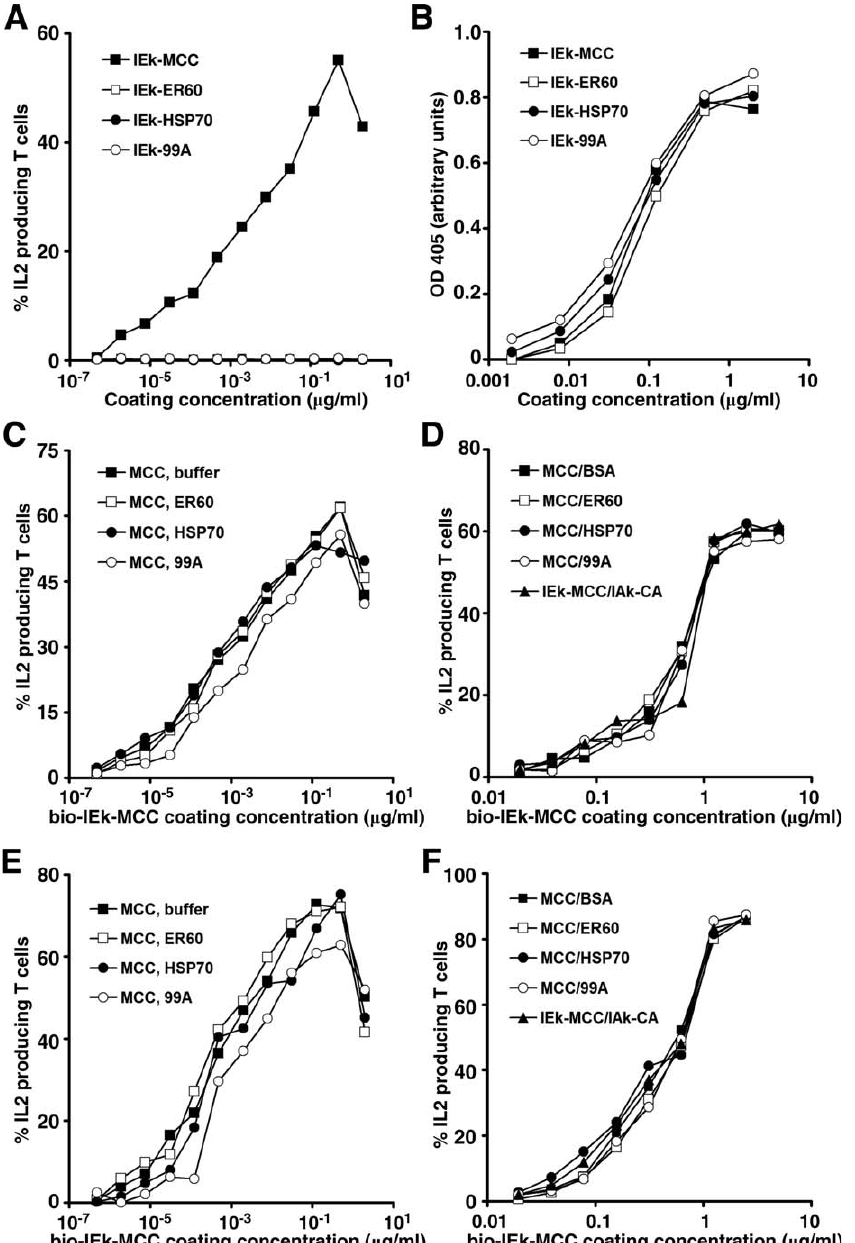
Figure 3. Very Low Numbers of Agonist IEk Anchored on a Fixed Surface Induce AD10 T Cell IL2 Production, Independent of Endogenous or Null IEk, or IAk (A) Bio-IEk-MCC, bio-IEk-ER60, bio-IEk-HSP70, or bio-IEk-99A at the indicated concentrations were added to 96-well plates precoated with streptavidin and incubated for 18 h at 37 8 C. AD10 CD4 þ T cells were added to the wells and stimulated for 7 h prior to IL2 assay. (B) The level of IEk proteins on streptavidin plates coated as in (A) was determined by ELISA using anti-IEk 14-4-4s antibody followed by HRP-conjugated goat anti-mouse antibody. ABTS substrate color development was monitored at 405 nm. (C) Streptavidin plates coated with bio-IEk-MCC at the indicated concentrations were subsequently saturated with 10 l g/ml bio-IEk-ER60, bio-IEk- HSP70, bio-IEk-99A, or buffer for 1 h at room temperature before being used to stimulate AD10 T cells. (D) The 96-well ELISA plates were coated with bio-IEk-MCC at the indicated concentrations overnight at 4 8 C. The wells were then saturated with 10 l g/ ml BSA, IEk-ER60, IEk-HSP70, IEk-99A, or IAk-CA for 4 h at room temperature. Stimulation of AD10 and measurement of IL2 measurements were done as described in (A). (E and F) Same as (C) and (D), respectively, except that 5C.C7 cells were used.